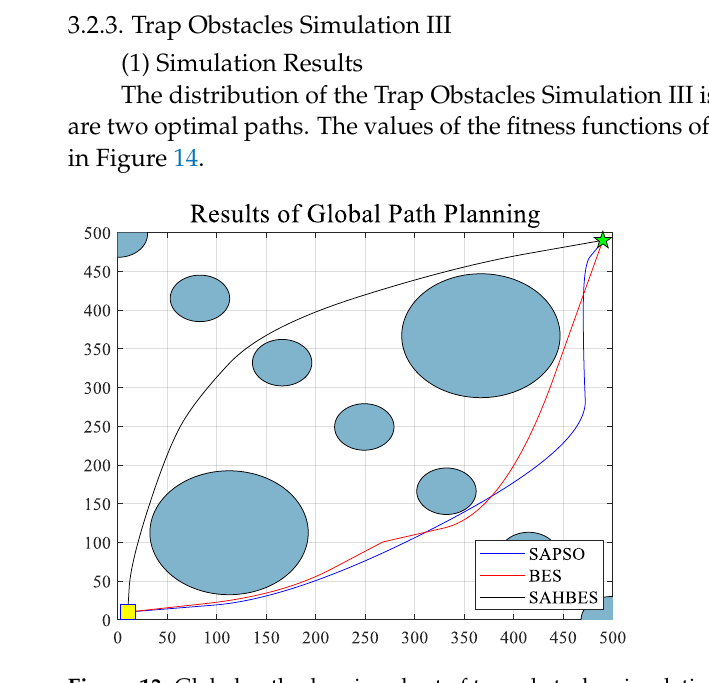
Figure 13. Global path planning chart of trap obstacles simulation III.